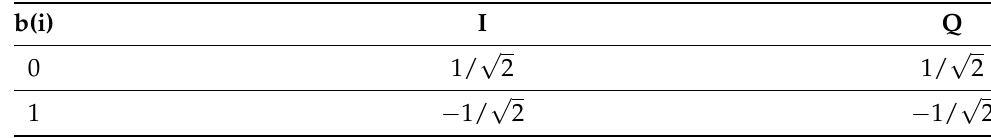
Table 5. BPSK modulation